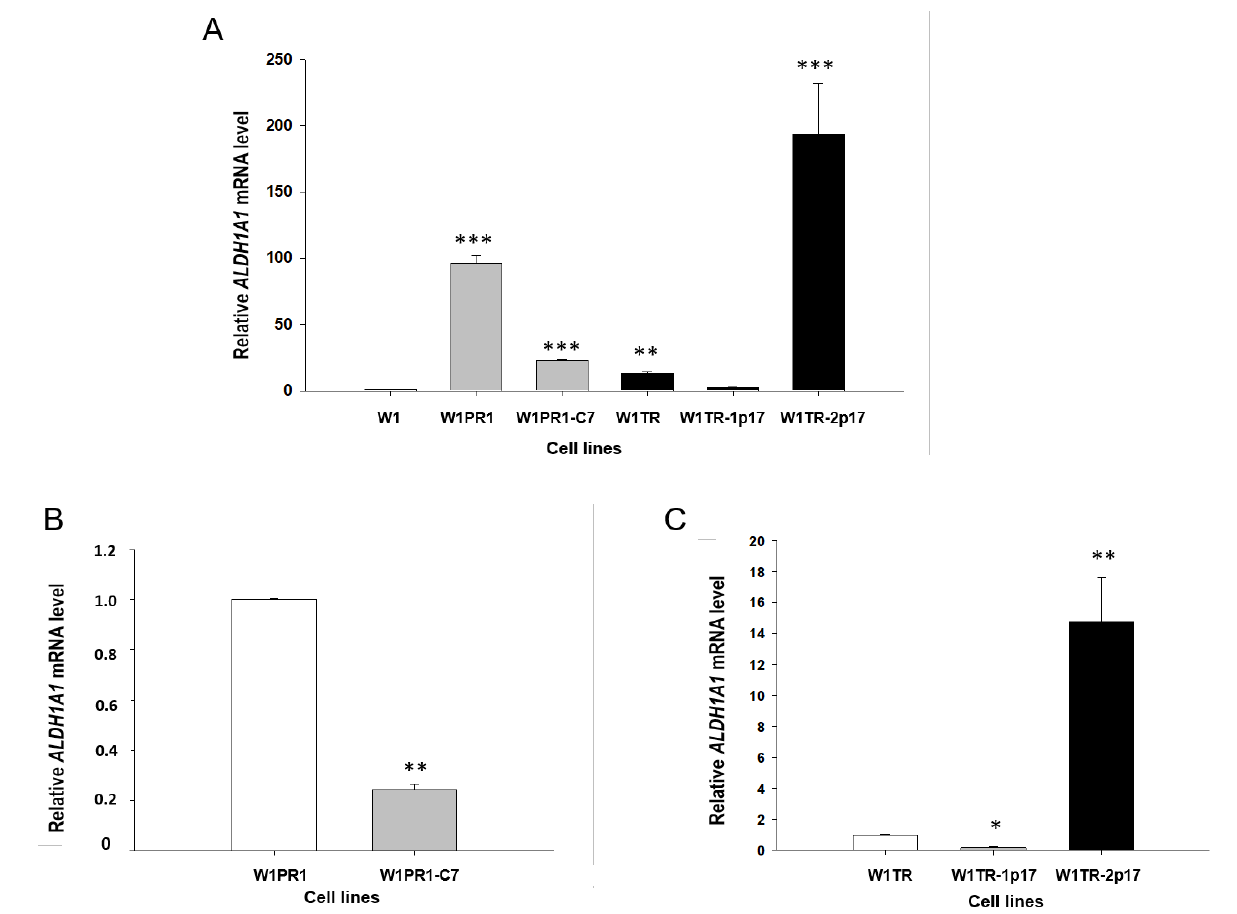
Figure 1. ( A ) Expression analysis of ALDH1A1 transcript (Q-PCR) in the W1, W1PR1, W1PR1-C7, W1TR, W1TR-1p17 and W1TR-2p17 cell lines. The figure presents the relative gene expression in the PAC (paclitaxel)-resistant cell lines (gray bars), TOP (topotecan)-resistant cell lines (black bars) with respect to that in the sensitive cell line (W1) (white bar), which has been assigned a value of 1. ( B ) Expression analysis of ALDH1A1 transcript (Q-PCR) in the W1PR1 and W1PR1-C7 cell lines. The figure presents the relative gene expression in W1PR1-C7 cell line (gray bar) with respect to that in the W1PR1 cell line (white bar), which has been assigned a value of 1. ( C ) Expression analysis of ALDH1A1 transcript (Q-PCR) in the W1TR, W1TR-1p17, W1TR-2p17. The figure presents the relative gene expression in the W1TR-1p17 cell line (gray bar) and W1TR-2p17 cell line (black bar) with respect to that in W1TR cell line (white bar), which has been assigned a value of 1. The values were considered significant at * p < 0.05, ** p < 0.01, and *** p < 0.001. Knockout of the ALDH1A1 gene was confirmed at the protein level by Western blot analysis (Figure 2A). The ALDH1A1 expression in drug-sensitive W1 and drug-resistant cell lines was assessed by Western blot analysis. W1 cells showed no ALDH1A1 protein expression. A very strong ALDH1A1 protein expression was observed in W1PR1 and W1TR-2p17 cell lines. Additionally, the presence of a weak band was observed in W1TR cell line.